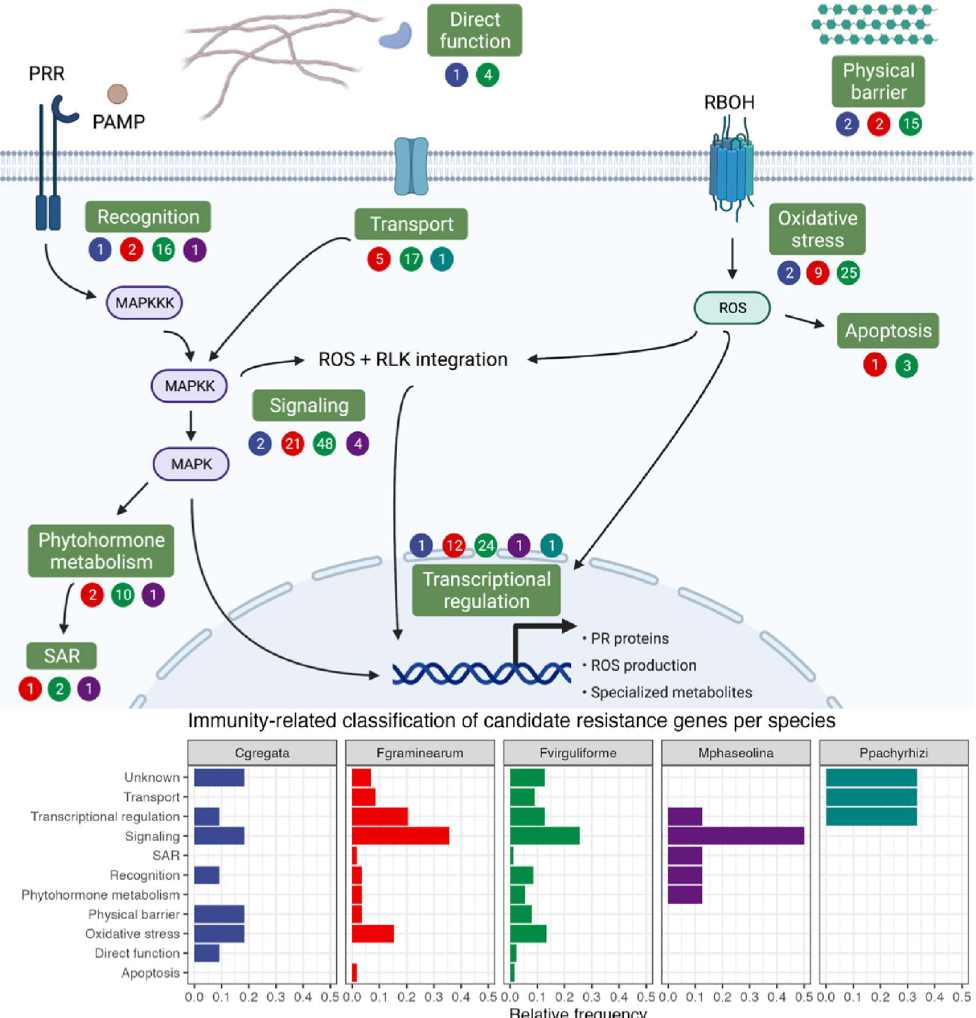
Figure 3. Prioritized candidate resistance genes and their putative role in plant immunity. Numbers in circles represent absolute frequencies of resistance genes against C. gregata (blue) , F. graminearum (red) , F. virguliforme (green) , M. phaseolina (purple) , and P pachyrhizi (turquoise). PRR, pattern recognition receptor. PAMP, pathogen-associated molecular pattern. MAPKKK, mitogen-activated protein kinase kinase kinase. MAPKK, mitogen-activated protein kinase kinase. MAPK, mitogen-activated protein kinase. SAR, systemic acquired resistance. RBOH, respiratory burst oxidase homolog. ROS, reactive oxygen species. RLK, receptor-like kinase. PR, pathogenesis-related. Figure designed with Biorender